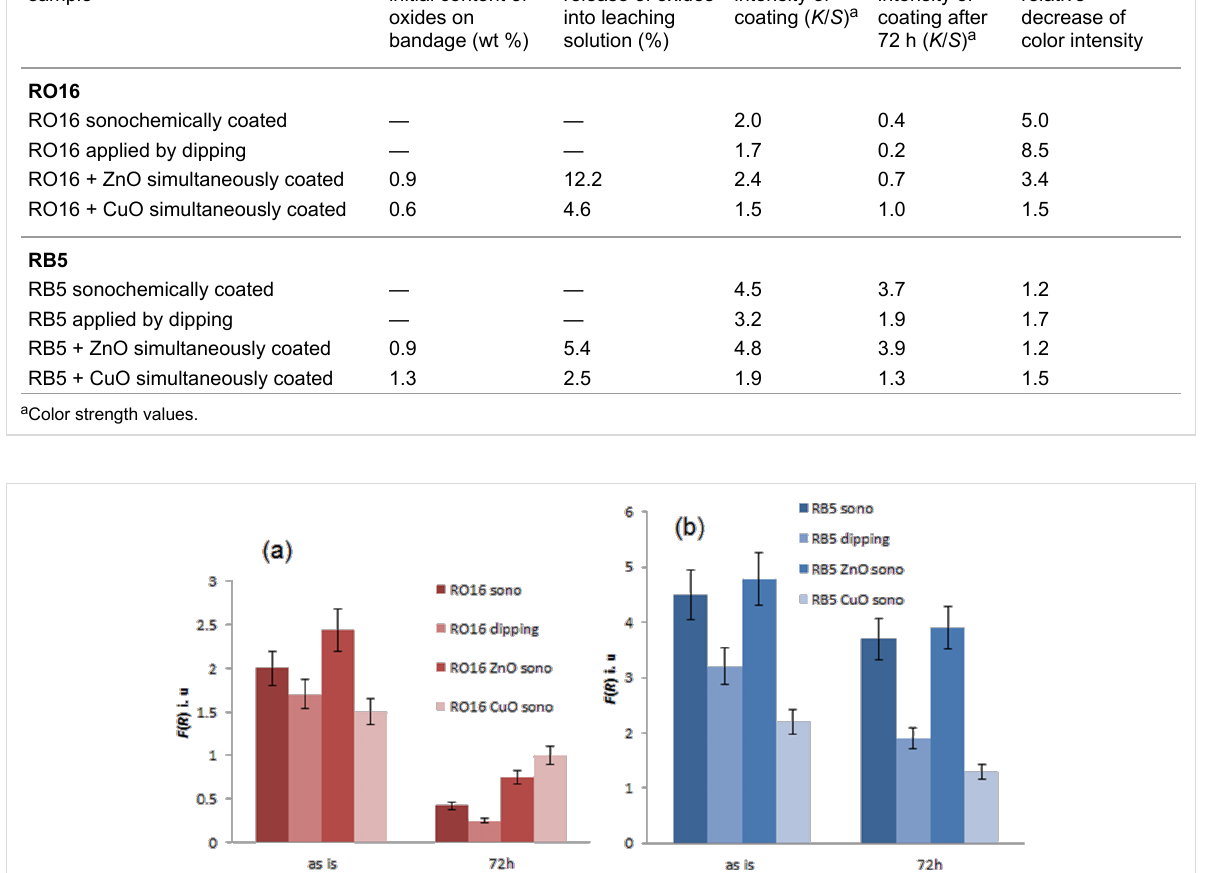
Table 2: Comparative studies of fabric coating based on absorption and ICP-OES data. sample